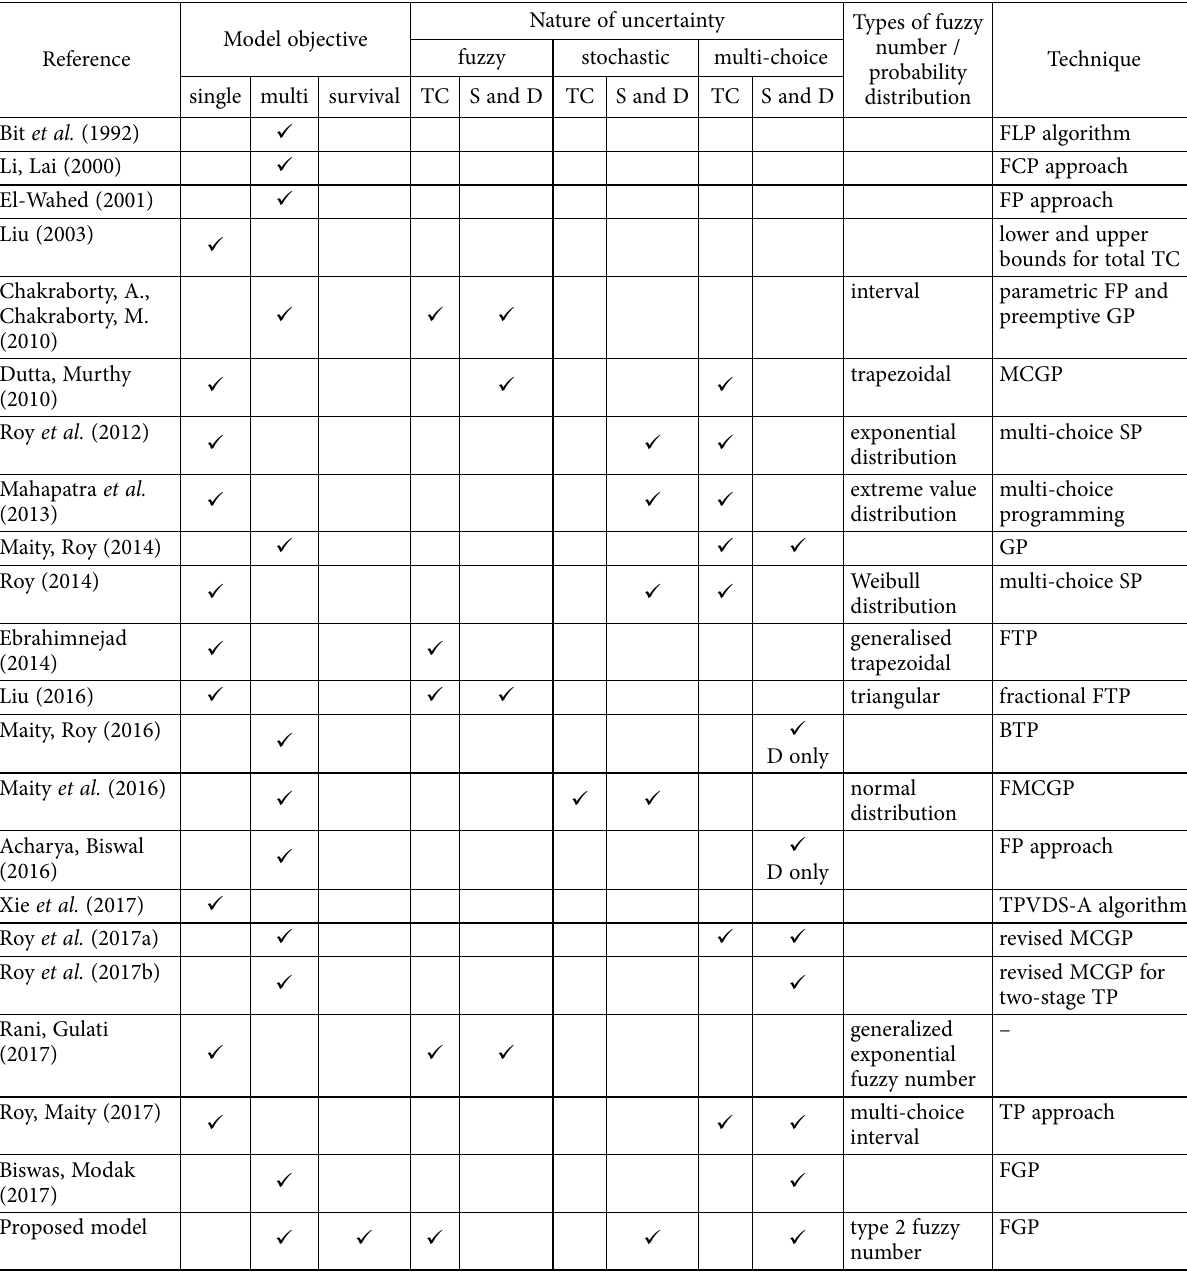
Table 1. Review of some existing